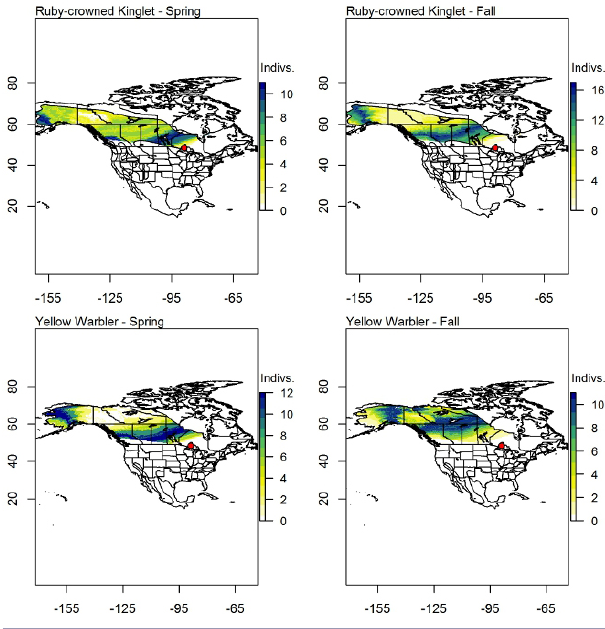
Fig. 10 . Probable origins of Ruby-crowned Kinglet ( Regulus calendula ) and Yellow Warbler ( Setophaga petechia ) captured at Thunder Cape Bird Observatory in northwestern Ontario during spring and fall migration. Red dots indicate locations of Canadian Migration Monitoring Network stations used in the analysis. Scales indicate the number of individuals that were isotopically consistent with similarly colored pixels in the map